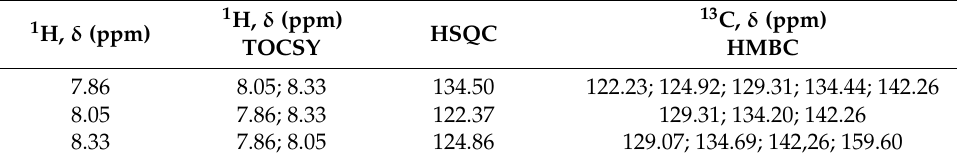
Figure 1. Main HMBC ( 3 J) correlations and assignments of signals (ppm) in the 1 H and 13 C NMR spectra of compound AL14. Table 1. Correlations found in the TOCSY, HSQC, and HMBC spectra of compound AL14. 1 H, δ